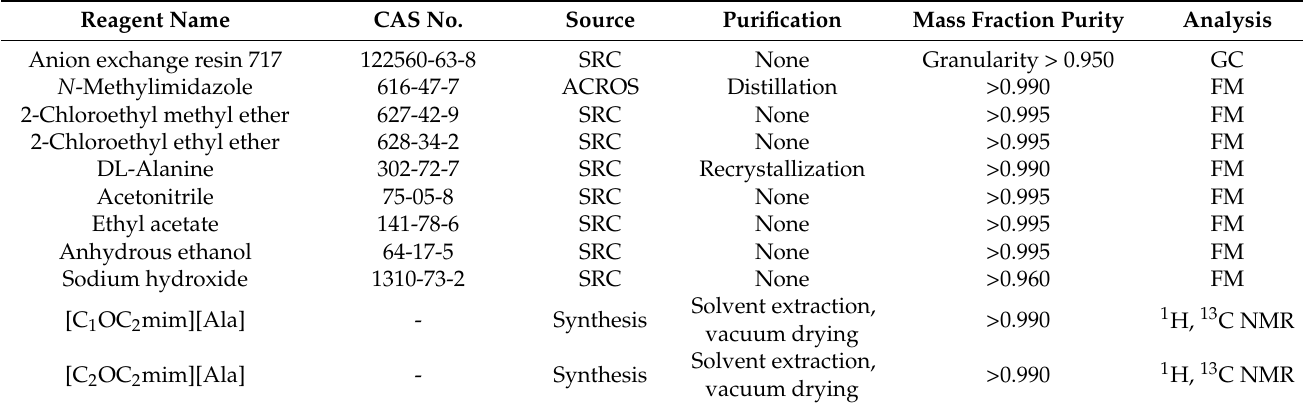
Table 8. Source and purity of